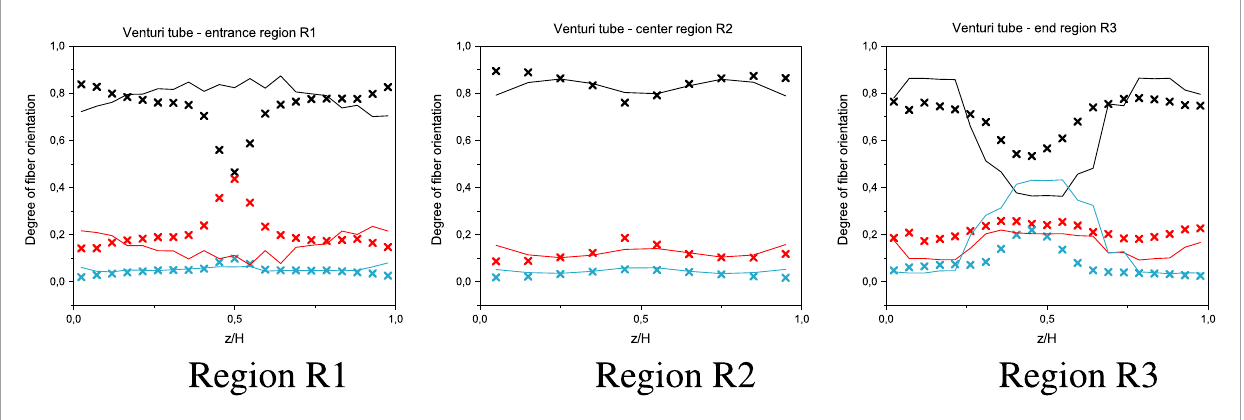
FIGURE 11 Fiber orientation distributions using the iARD-RPR-model with 3 parameters derived by Quintana et al. (2020) X : CT measurements, lines: simulation results, fiber orientation directions: black: xx (in-flow), red: yy (across flow), teal: zz (through-thickness).